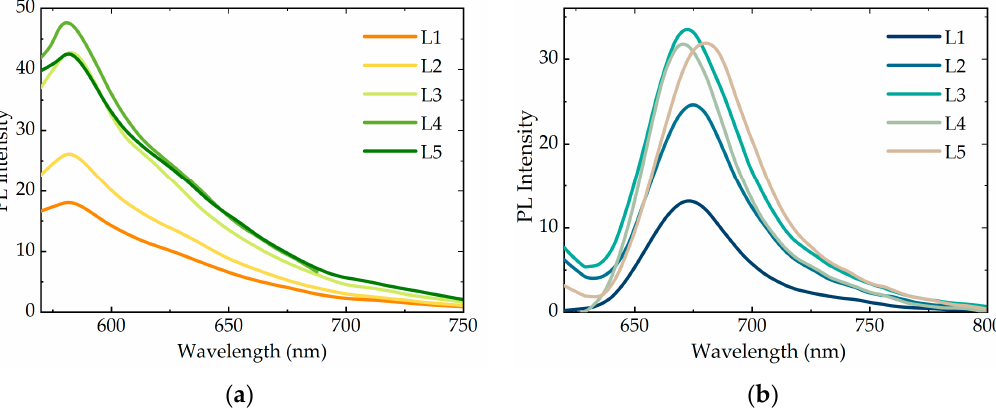
Figure 5. PL spectra of ( a ) PMS-AIS-Cy3 and ( b ) PMS-AIS-Cy5 with 1-5 double layers of polyelectrolytes. Excitation wavelength is 520 and 600 nm, respectively.